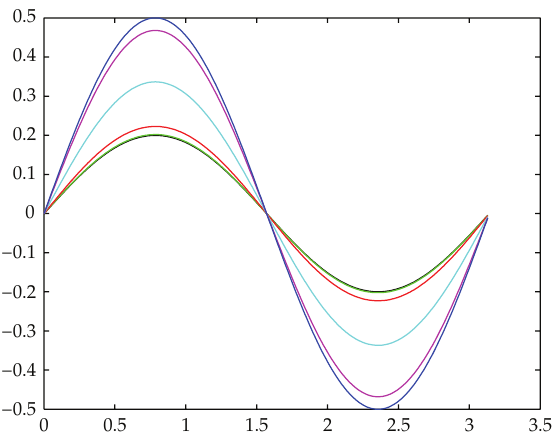
Figure 4: The exact solution and the regularized solutions corresponding to δ i , i (cid:5) 1 ,..., 8 at initial time t (cid:5)